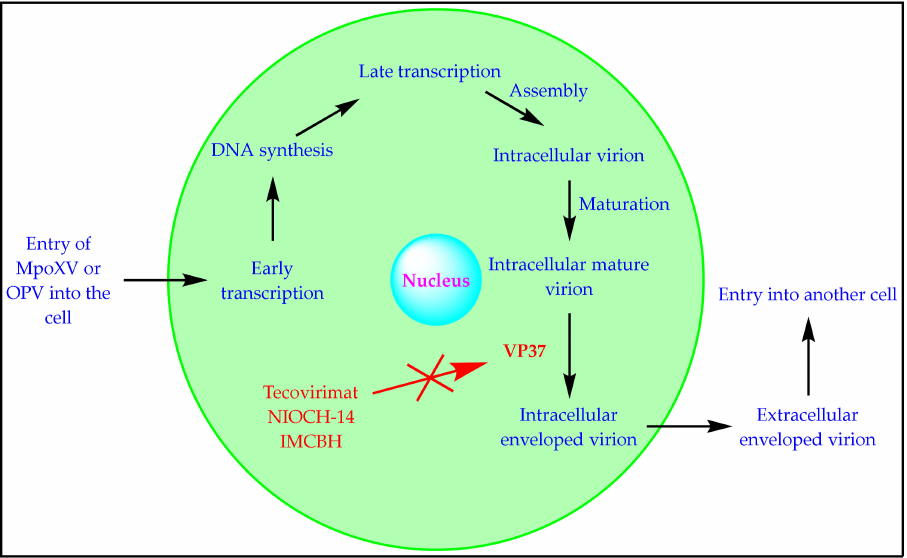
Figure 2. The replication cycle of an OPV/MpoxV.